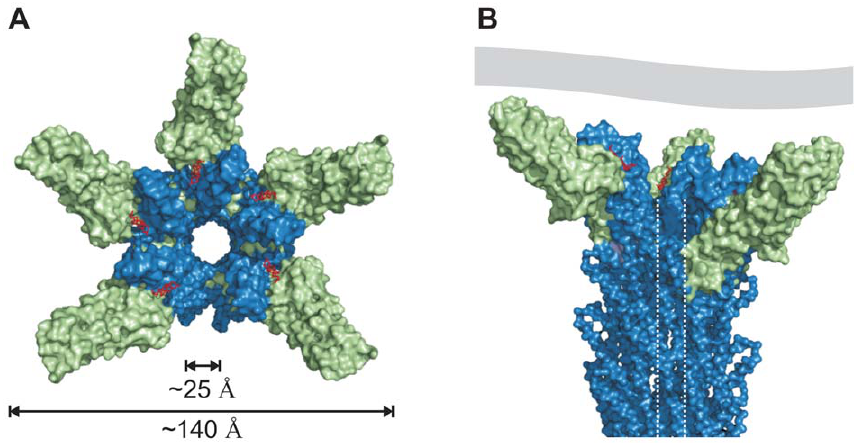
Figure 7. Model of the open state of the T3SS needle tip. (A) View from the surface into the channel opening of the T3SS needle tip. SipD is coloured in green and PrgI in blue, respectively. Deoxycholate molecules binding to PrgI-SipD D D1 are highlighted in red. The inner diameter of the needle tip complex (25 A˚) permits passage of unfolded virulence proteins. Opening of the needle tip complex with an outer diameter of 140 A˚ results in a large inner cavity which could be closed through contact with the plasma membrane of host cells. (B) Side view of the T3SS needle including the tip complex. The inner channel is highlighted by dotted lines and a contacting host cell membrane is shown in grey.